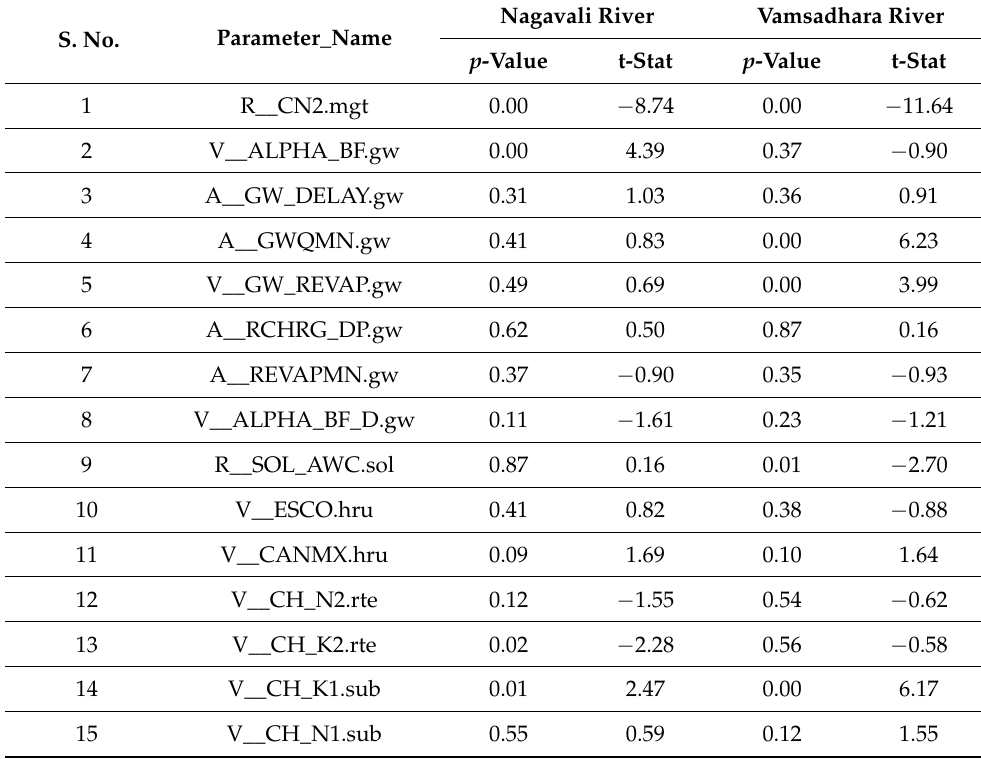
Table 3. Parameters that are sensitive in the Nagavali and Vamsadhara river basins.